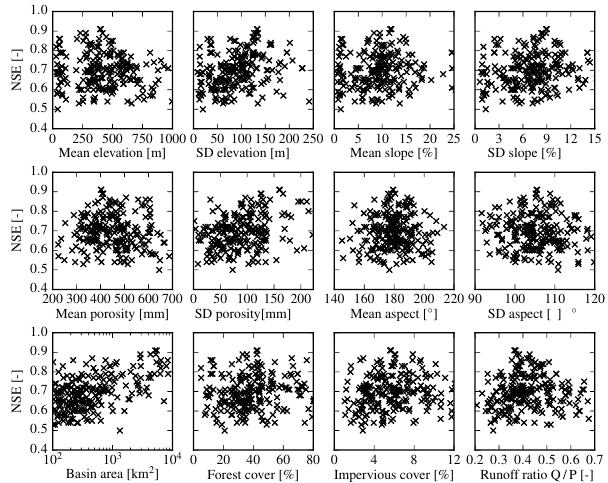
Figure B1. Relation between land surface and hydro-climatic con- ditions and model performance for the 222 river basins. The loca- tion of the basins is depicted in Fig. 4. The mean and standard devi- ation (SD) of a characteristic for the single basins are based on the morphological input data at the 100m × 100m